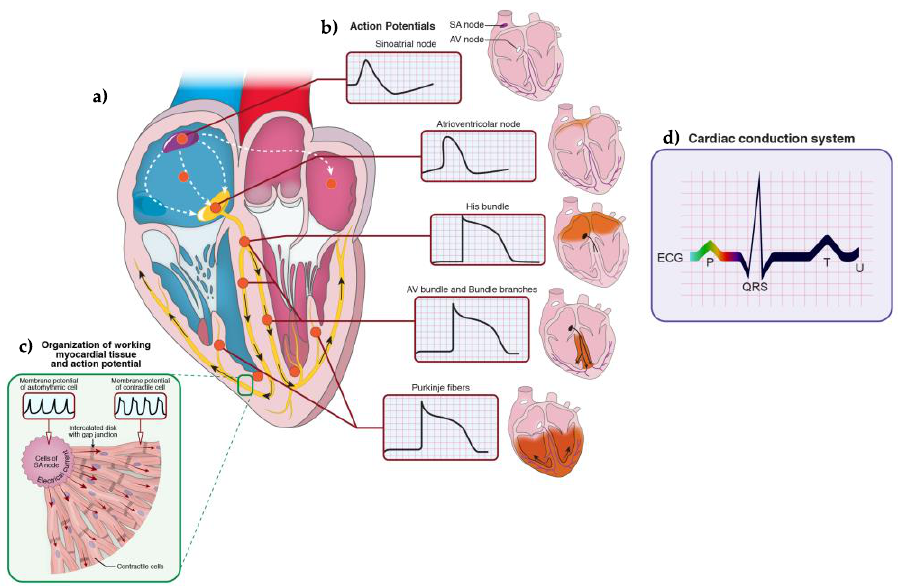
Figure 1. The cardiac conduction system (CCS). ( a ) The stations of the CCS and their typical action potential: sinoatrial node (SAN), atrioventricular node (AVN), His bundle, AV bundle and bundle branches, and, finally, Purkinje fibers; ( b ) Heart regions activated by the CCS electrophysiological activity during the cardiac cycle; ( c ) The working myocardium: architecture and action potential; and ( d ) Electrocardiogram (ECG) of a healthy subject.